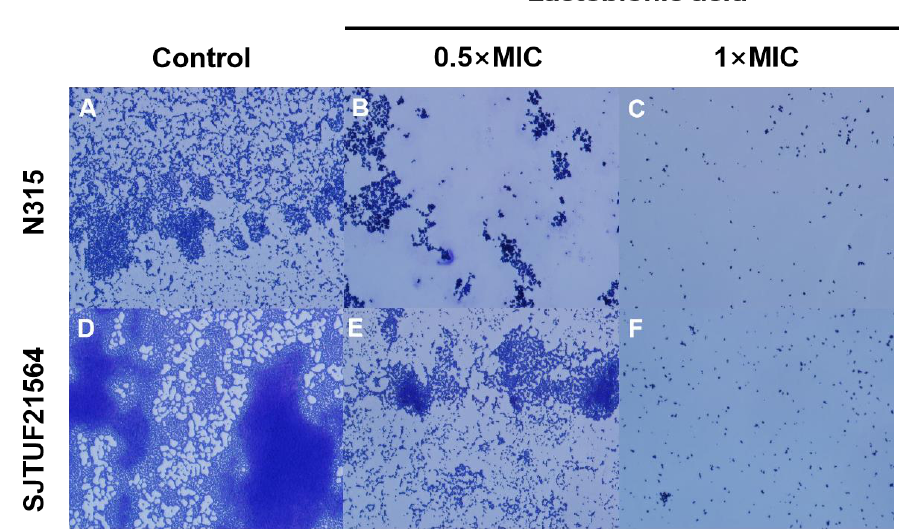
Figure 2. Light microscopy images of S. aureus biofilms inhibited with LBA at different concentrations. ( A , D ) are the controls, ( B , E ) are induced with 0.5 × MIC, and ( C , F ) are induced with 1 × MIC.